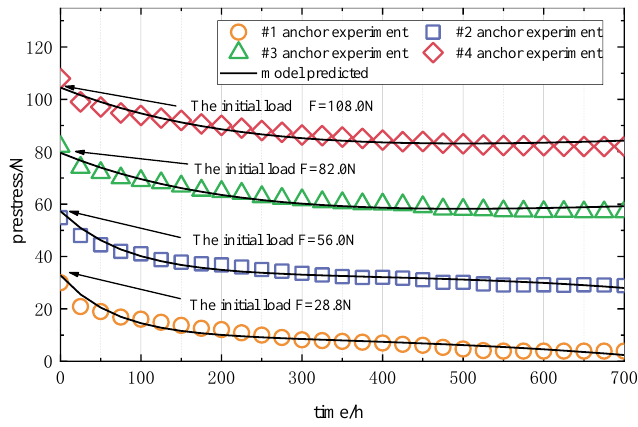
Figure 8. The #1–#4anchor rods’ relaxation test and prediction Figure 8. The #1 – #4anchor rods ’ relaxation test and prediction curves. Table 2. Correlation coefficient between model test and prediction.